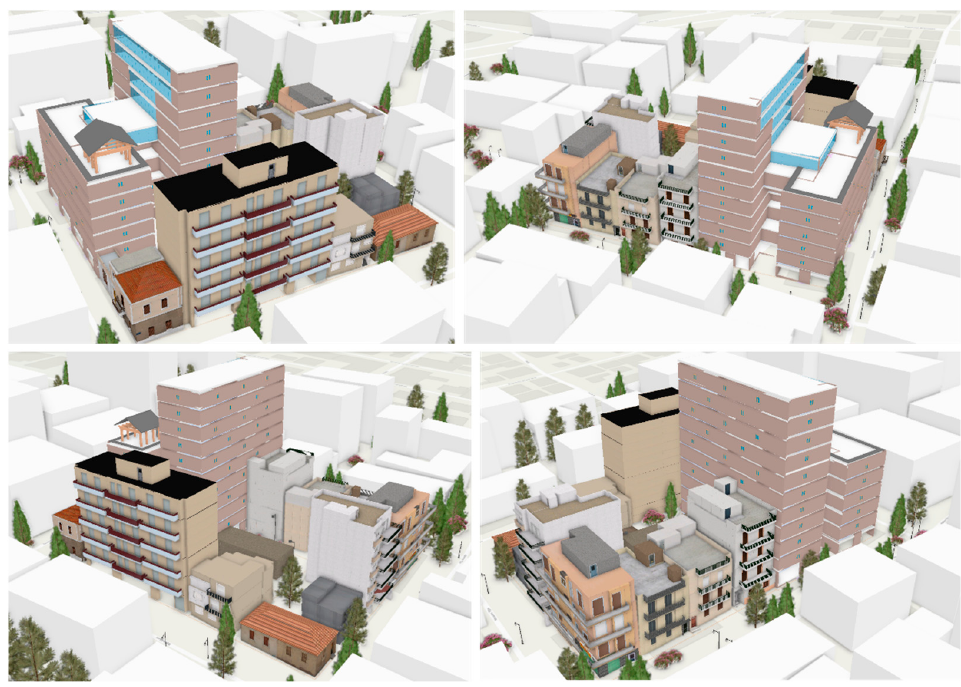
Figure 6. 3D views of the urban block of interest in the future scenario, where the new building is illustrated, along with the existing ones, in LoD3.